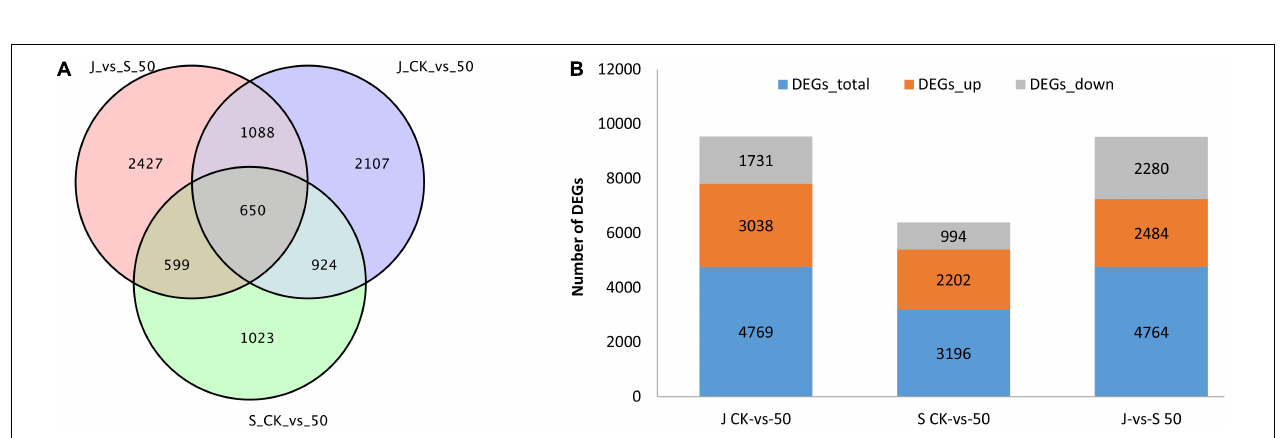
FIGURE 4 | DEGs comparison of 62\3 and JB231AC. (A) Venn diagrams showing all DEGs shared among the three groups. (B) Number of DEGs that were up or down-regulated in the three groups. S: 62\3, J: JB231AC, CK: 0 µ M CdCl 2 · 2.5H 2 O, 50: 50 µ M CdCl 2 · 2.5H 2 O, vs., versus.